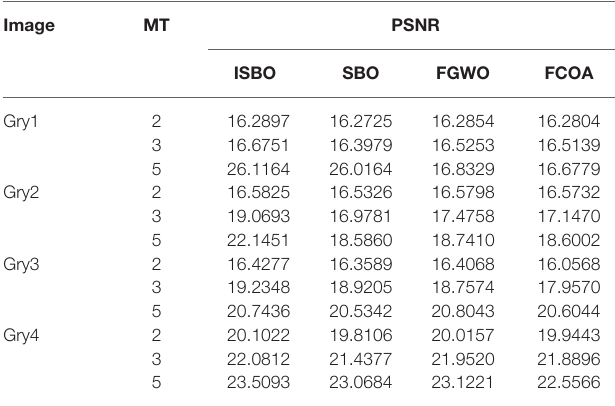
TABLE 9 | Comparison of experimental data of the plant images. Image MT PSNR ISBO SBO